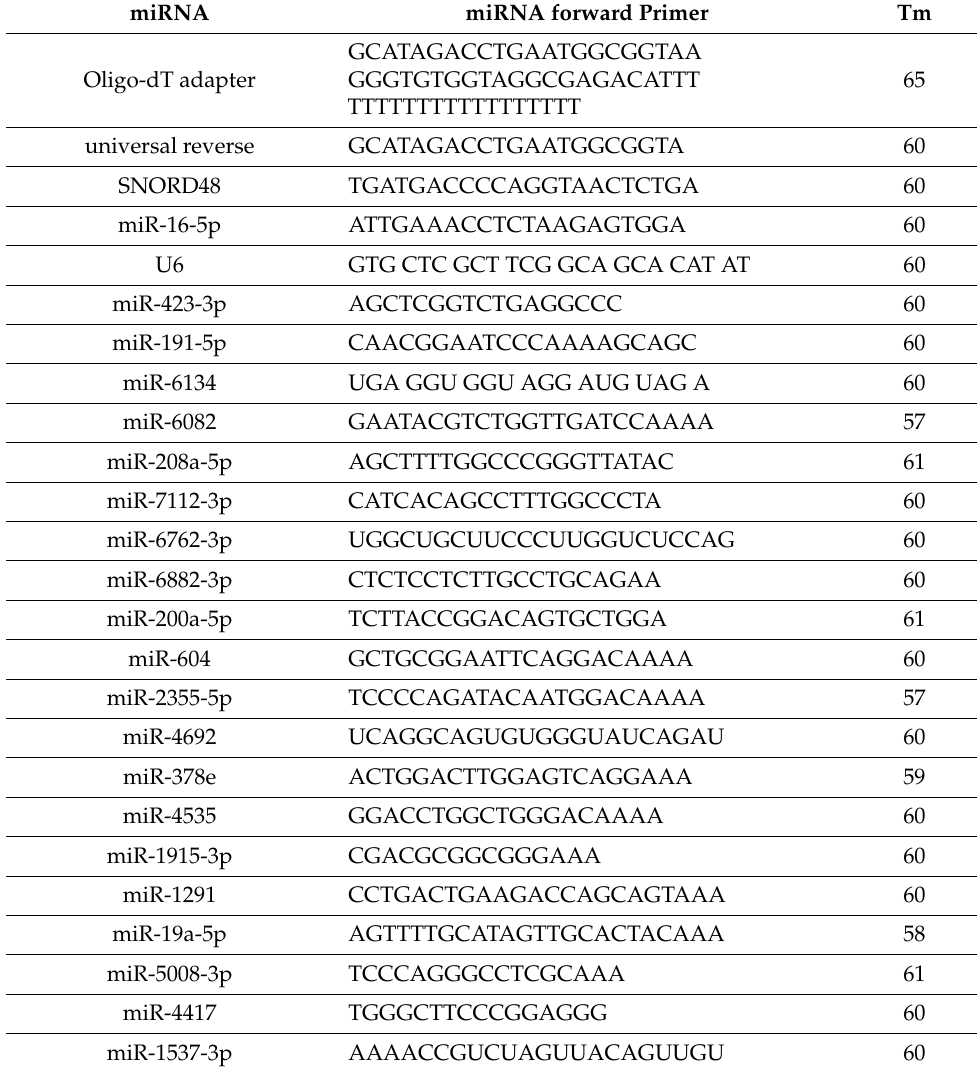
Table A1. RT-qPCR primers for miRNA gene expression